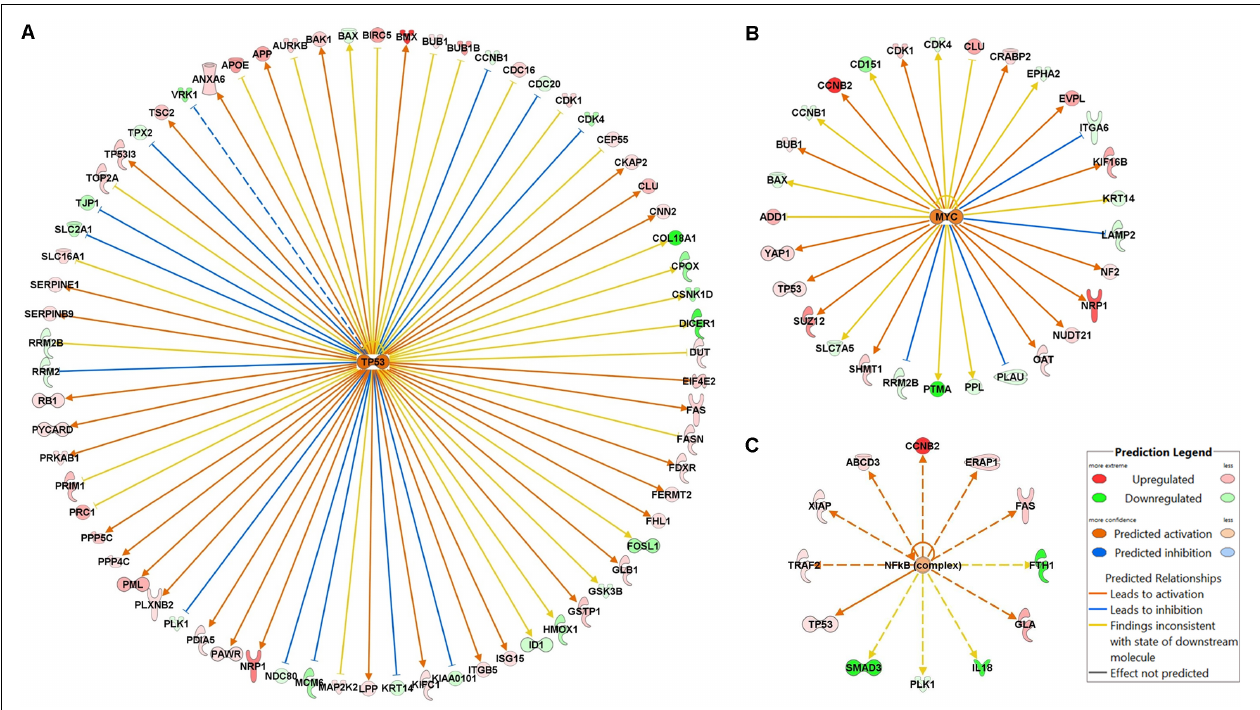
FIGURE 7 | Potential gemcitabine/birinapant effects on upstream regulatory proteins. Selected upstream regulator analysis was performed using Ingenuity Pathway Analysis for (A) p53, (B) Myc, and (C) NF- κ B. The figure box defines the connections and colors used to signify up- and down-regulation.